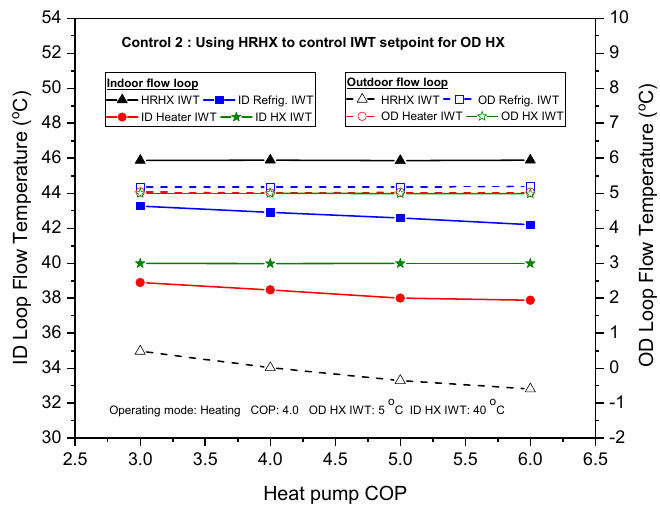
Figure 8. Flow loop temperature with heating COP variation in control (2).